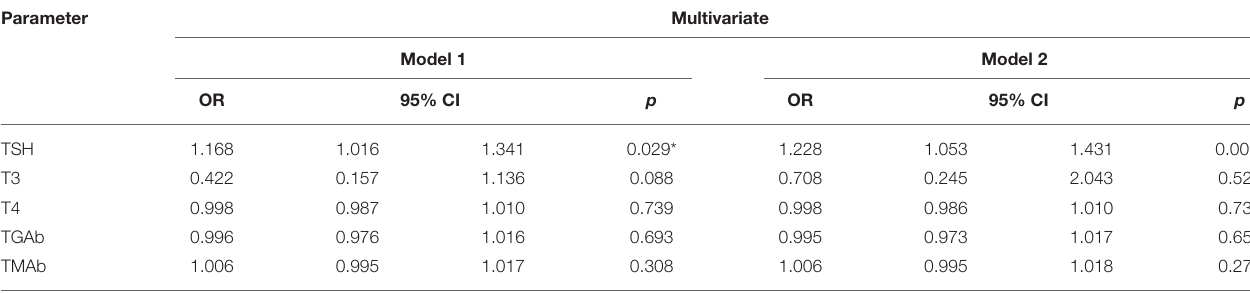
TABLE 2 | Multivariate logistic regression analysis between each thyroid hormone and PSD. Parameter